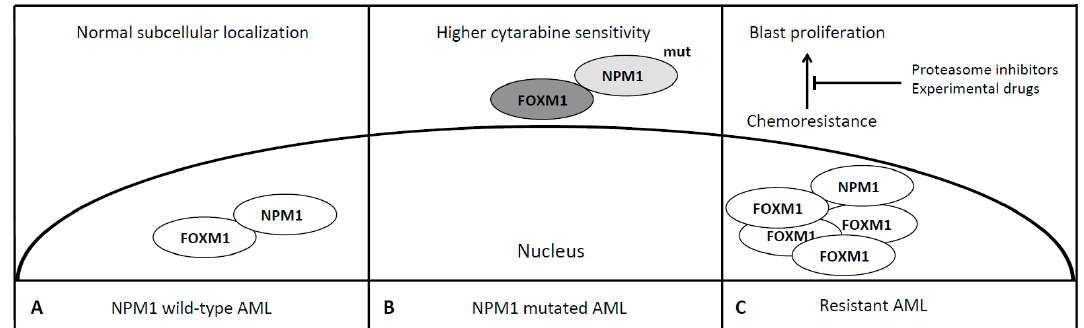
Figure 3. FOXM1 in NPM1 and refractory AMLs. In NPM1 wild-type AML, FOXM1 co-localizes with NPM1 in the nucleus in its active form ( Panel A ). In NPM1 mutated AML, the aberrant